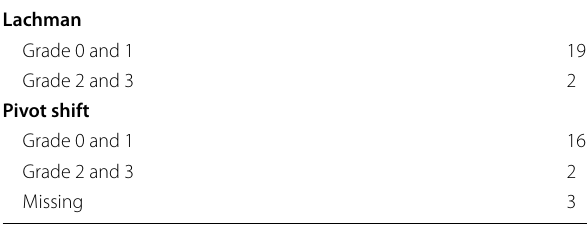
Table 6 The Lachman test and Pivot shift test at follow-up Lachman